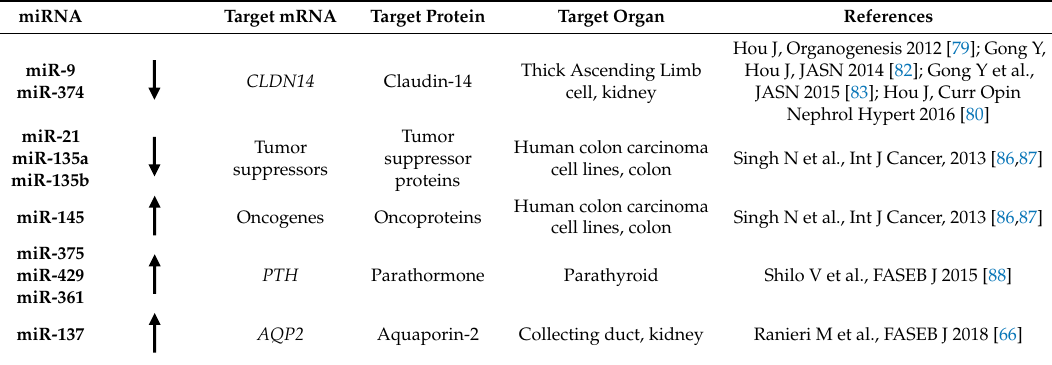
Table 1. MicroRNA expression downstream CaSR signaling.